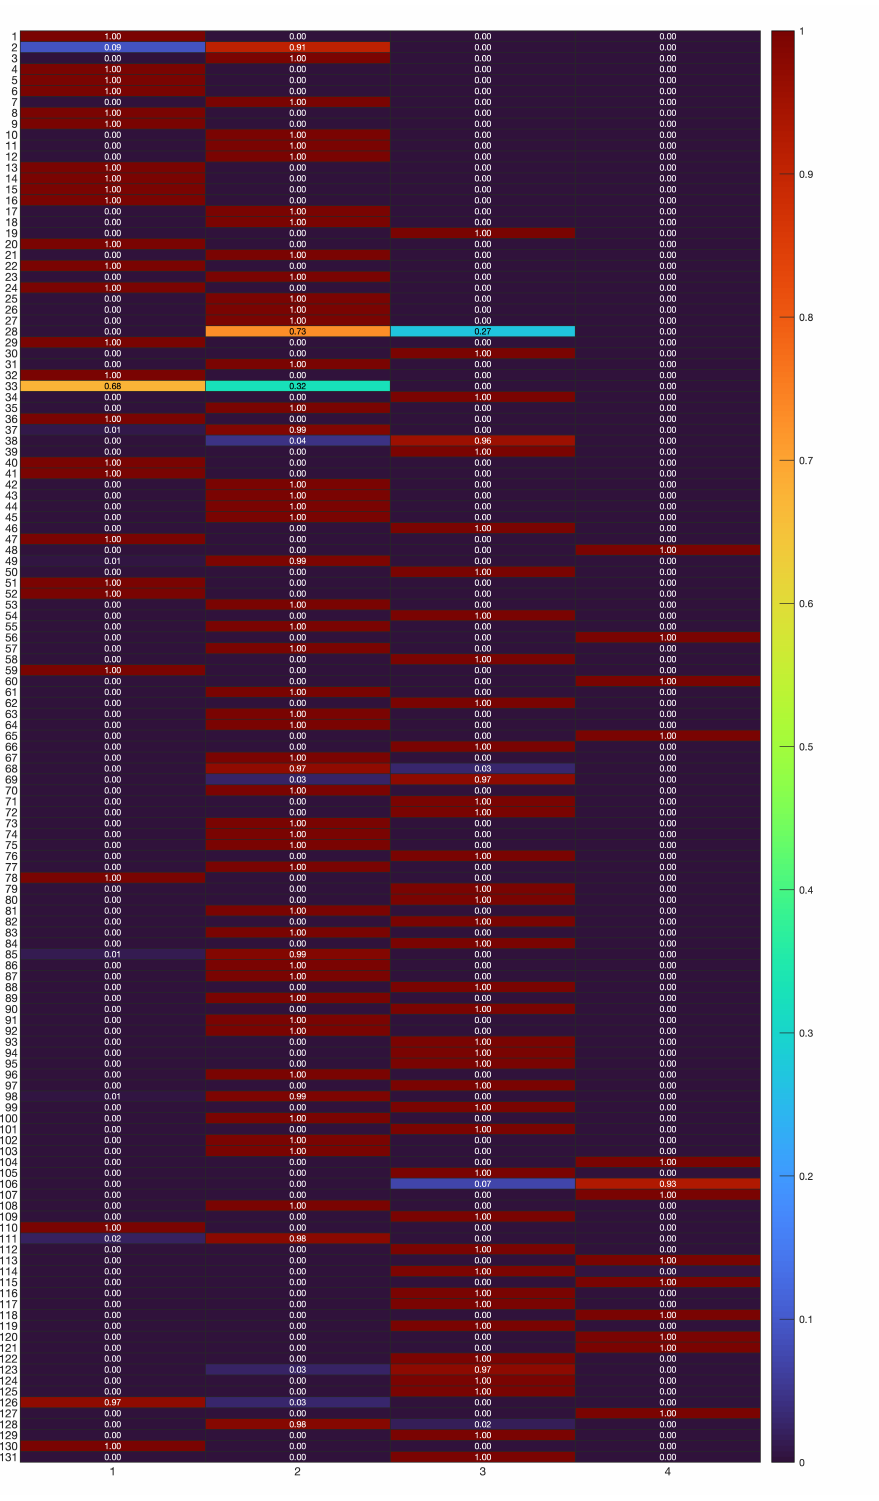
Figure 6. Classification results with polynomial regression mixtures. “Soft” partition of the 131 time series (rows) into K = 4 clusters (columns), represented by (cid:98) π ik in